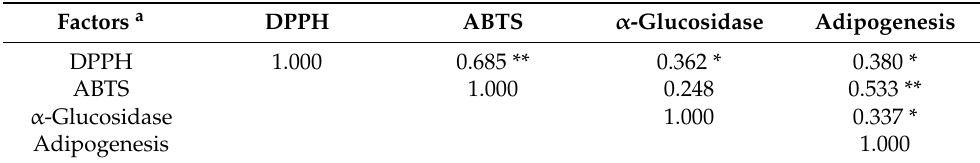
Table 1. Correlation analysis of the biological activities of the lactic acid bacteria.